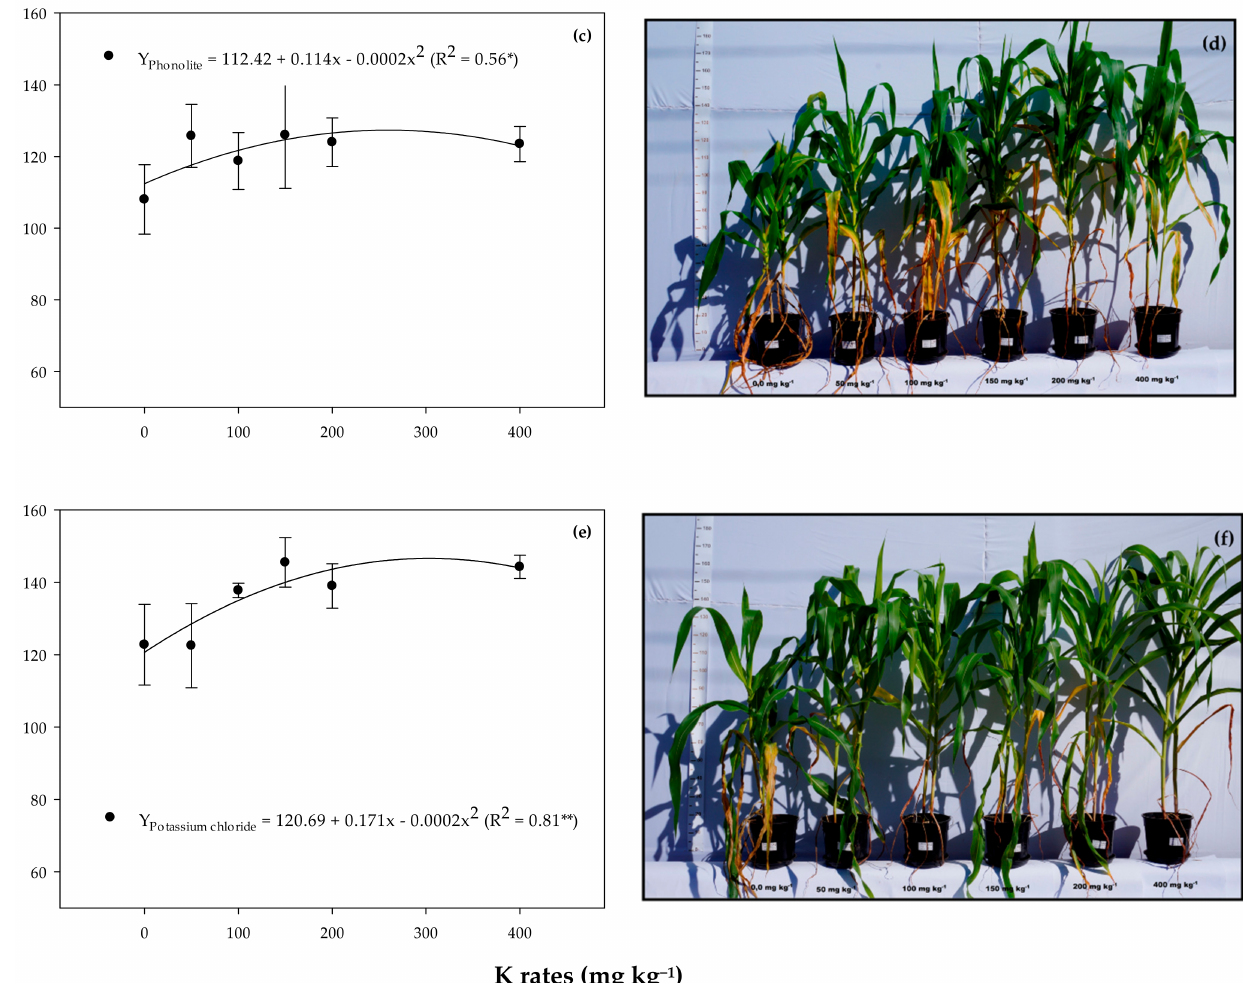
Figure 3. Plant height and comparative growth 45 days after emergence of maize grown in the Rhodic Hapludox with increasing rates of K via nepheline syenite ( a , b ), phonolite ( c , d ), and potassium chloride ( e , f ). *—Significant at the p < 0.05 level. **—Significant at the p < 0.01 level. Bars represent the standard error of the